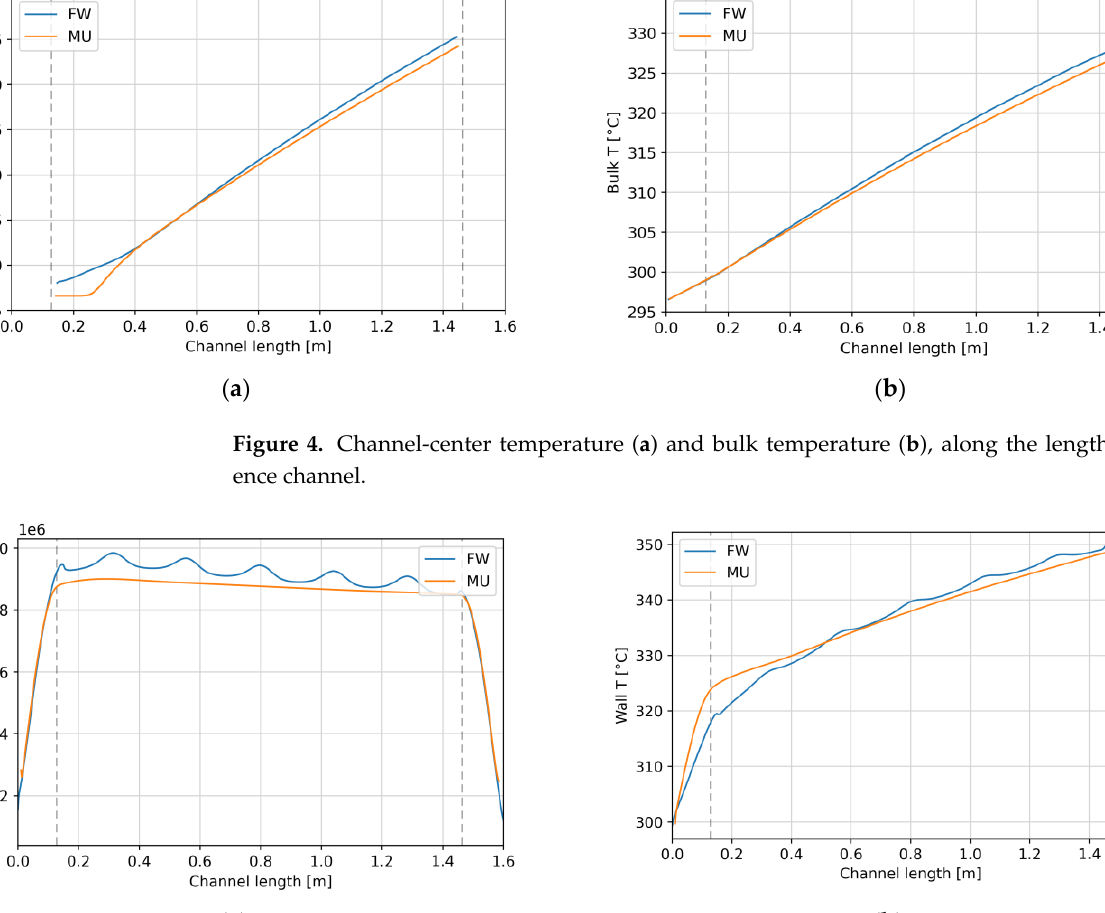
Figure 6. Wall temperature along the channel sides for the FW and the MU.